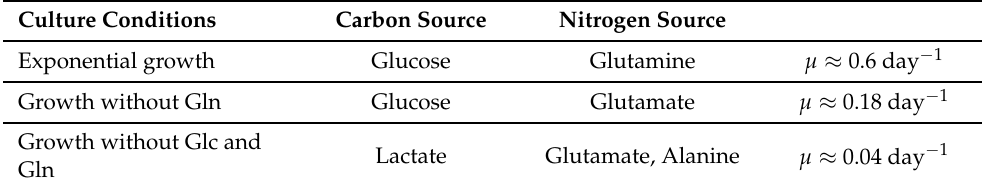
Table 1. Three different culture